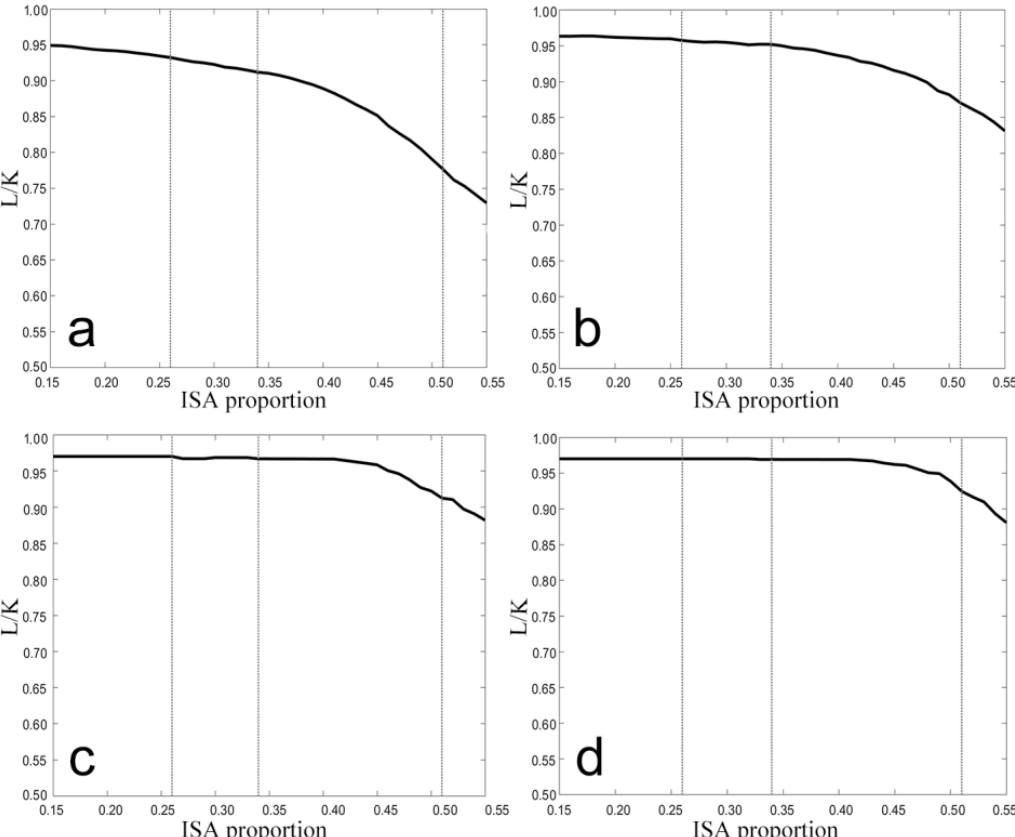
Figure 13. Effect of ISA proportion threshold on accuracy under adaptive threshold. ( a – d ) correspond to the subregions shown in Figure 7. Table 1. Value of L/K under different ISA proportions in four